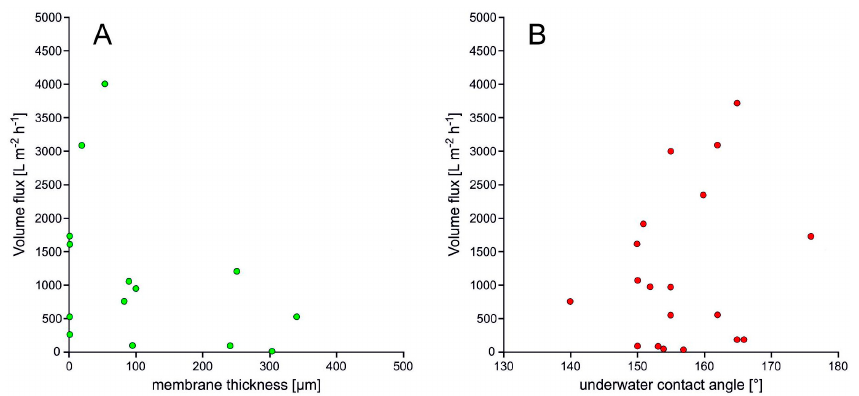
Figure 8. Volume flux of membranes depending from membrane thickness ( A ) and UWCA ( B ).